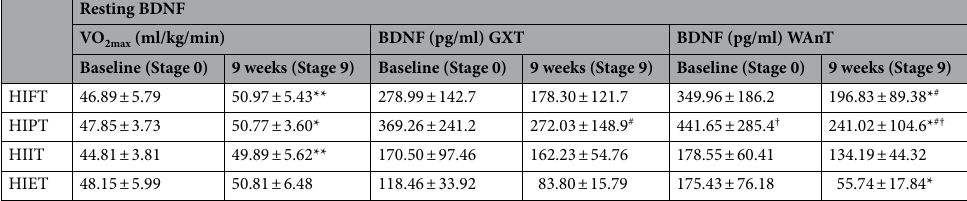
Table 3. VO 2 max and resting value of BDNF before GXT and WAnT at the baseline and after the 9 weeks. Data are presented as mean ± SD. *p < 0.05; **p < 0.01 in comparison to the baseline values. # p < 0.05 in comparison to HIET. † p < 0.05 in comparison to HIIT and HIET.